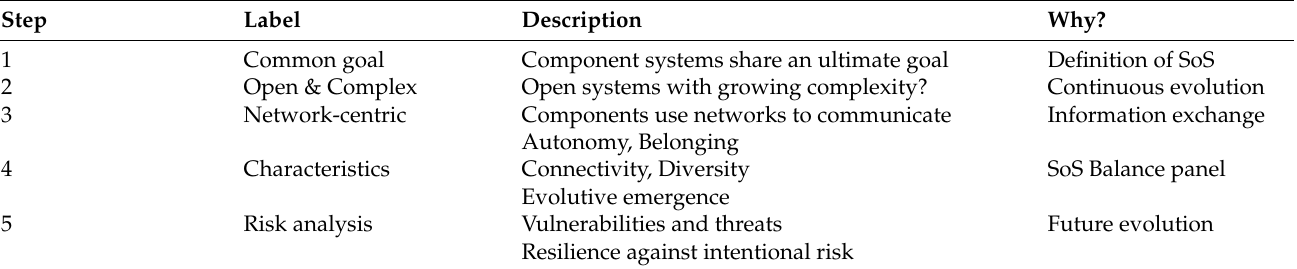
Table 3. SoSE-based methodology to manage complex